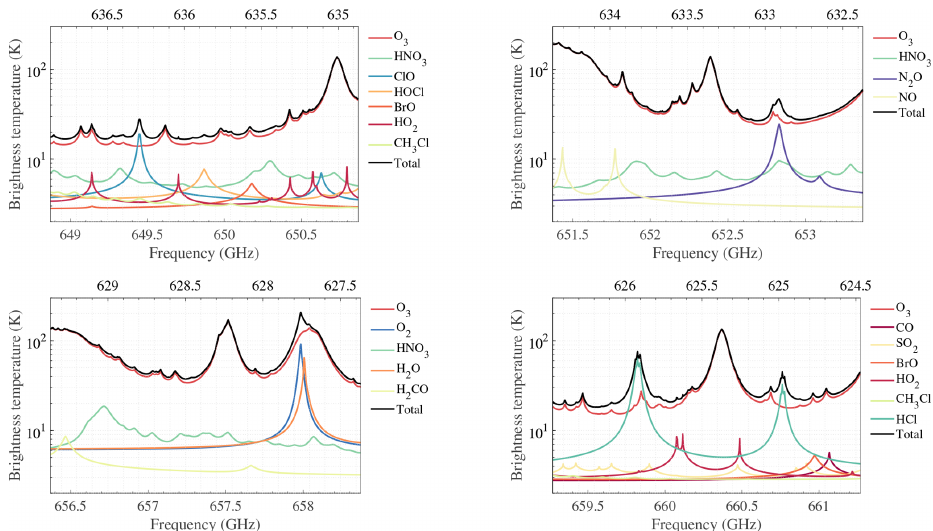
Figure 7. Contributions of the main target chemical species to the 643GHz spectra. The brightness temperature is measured from the double- sideband radiometer. The tangent height is 30km. The top axis represents the lower sideband frequencies and the bottom axis represents the upper sideband frequencies. Each panel represents a single